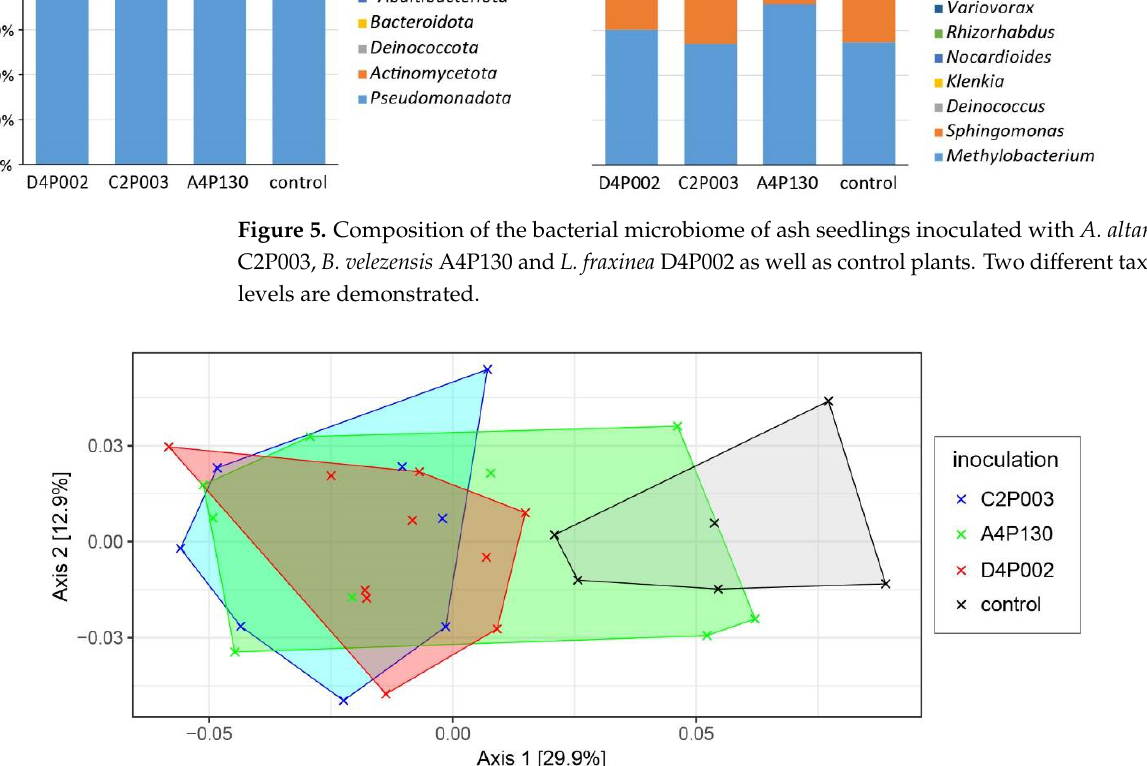
Figure 6. Ordination plot visualizing the bacterial microbiome composition of ash seedlings inocu- lated with A. altamirensis C2P003, B. velezensis A4P130 and L. fraxinea D4P002 as well as control plants. A principle coordinate analysis (PCoA) was applied based on the weighted UniFraq distance matrix.